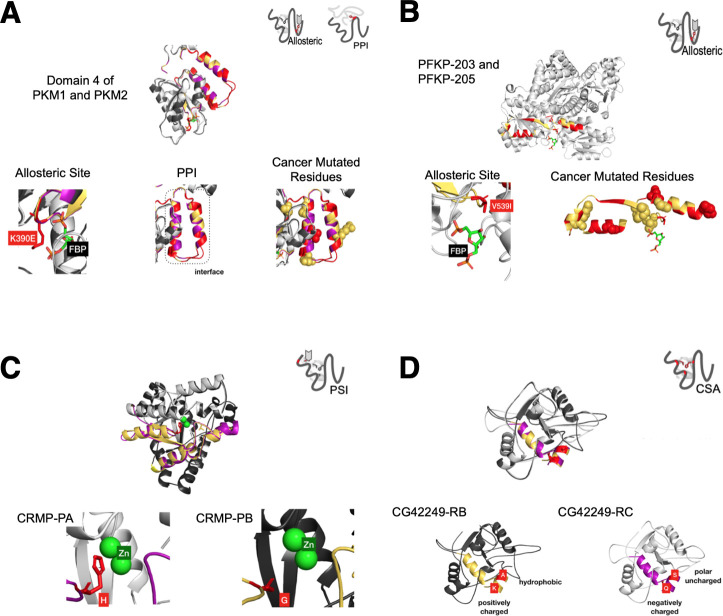
Examples of MXE events affecting amongst other things.(A) Protein-protein interaction of the PKM gene. Cancer mutated residues are shown in spacefill. (B) Allosteric regulation of the PFKP gene. Cancer mutated residues are shown in spacefill. (C) Small molecule interaction (PSI) sites in the CRMP gene. We are only showing variable binding zinc/catalytic residues. Zinc molecules are shown green spacefill. (D) Catalytic site residues of gene CG42249 from drosophila. We are only showing variable binding zinc/catalytic residues.